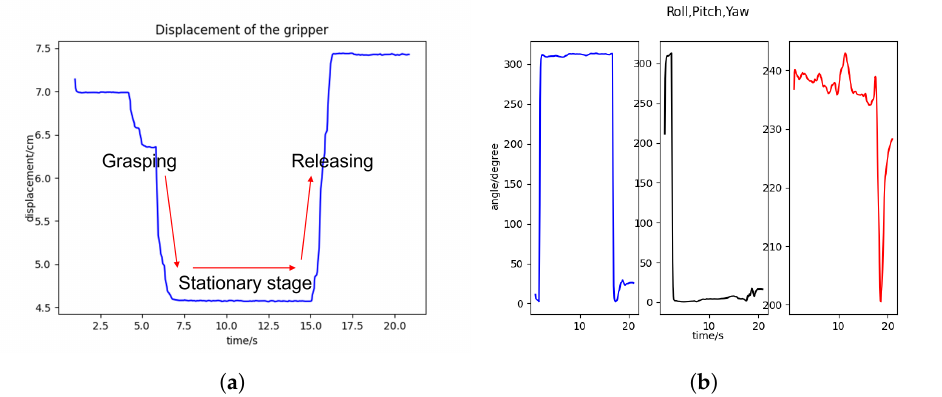
Figure 4. Data collected from displacement sensor and IMU sensor. ( a ) Gripper displacement. ( b ) Pose information of the exoskeleton.